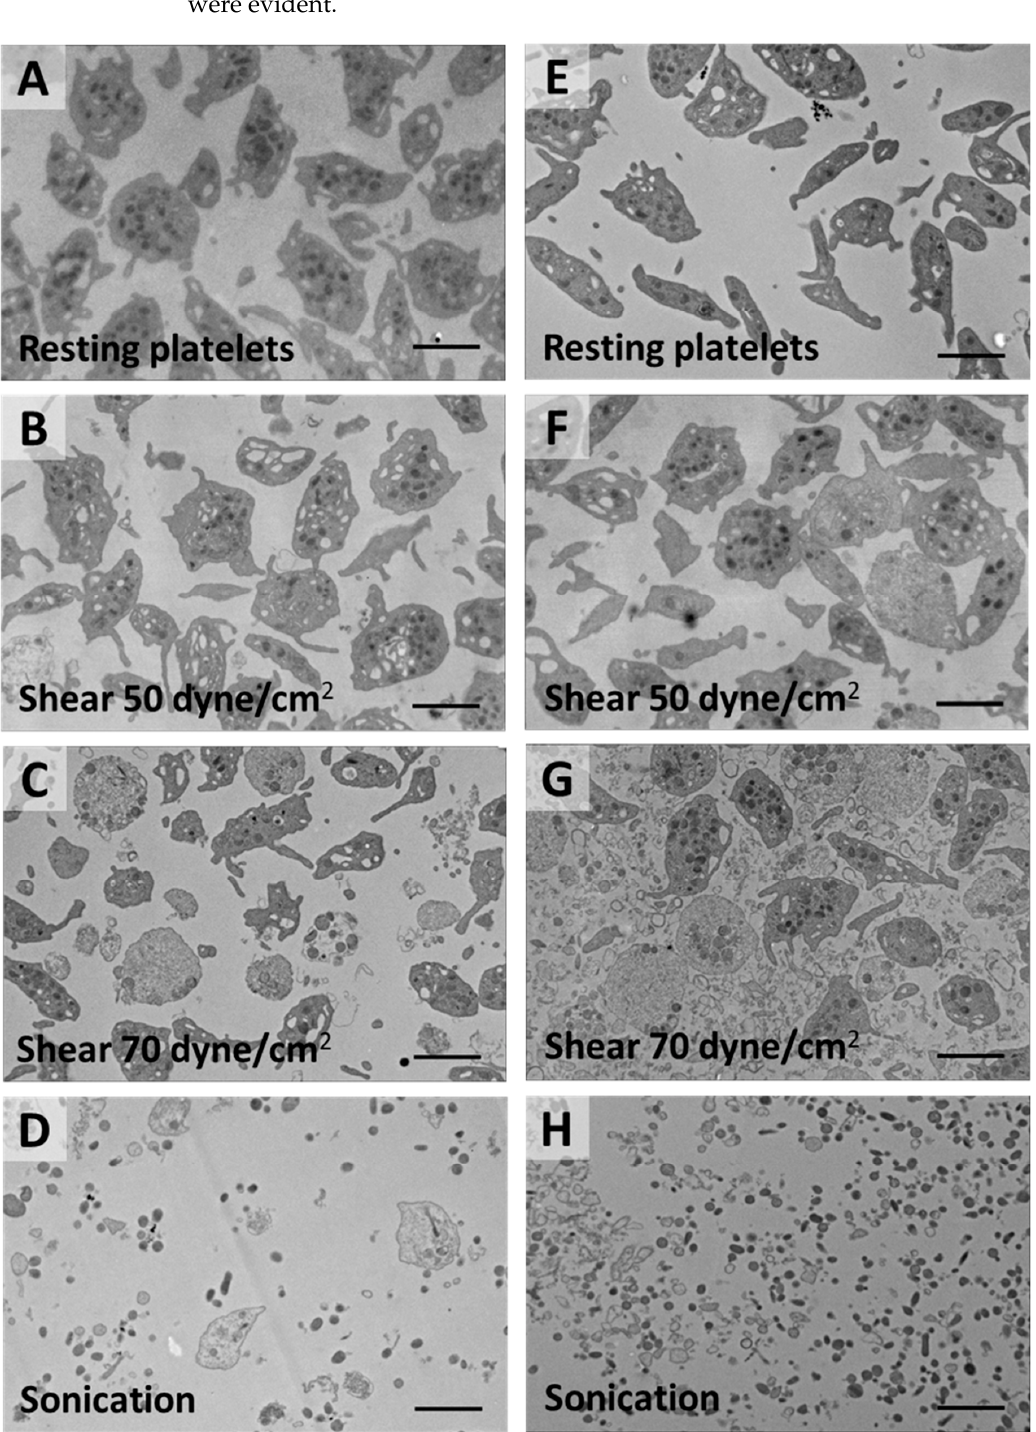
Figure 1. Shear stress of increasing magnitude and sonication promote alterations of platelet morphology and generation of platelet-derived microparticles. Illustrative transmission electron microscopy images of ( A – D ) platelets and ( E – H ) platelet-derived microparticles following exposure to shear stress (50 and 70 dyne/cm 2 ) and sonication. ( A – D ) Platelets were pelleted via low-speed centrifugation (1500 × g , 15 min). ( E – H ) Platelets and microparticles were pelleted by high-speed centrifugation (20,000 × g , 30 min). Scale bar represents 2 µ m. Direct magnification: 1200 × ( A ), 2900 × ( B , F ), and 3000× ( C – H ).